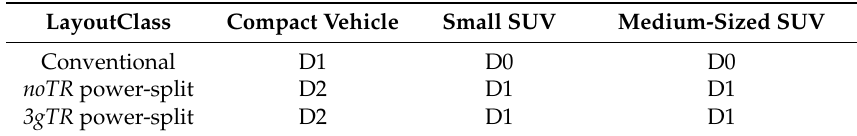
Table 3. Engines installed on each vehicle.